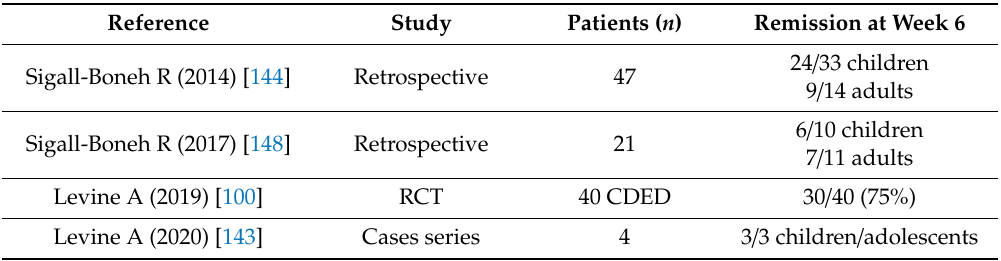
RCT: randomized control